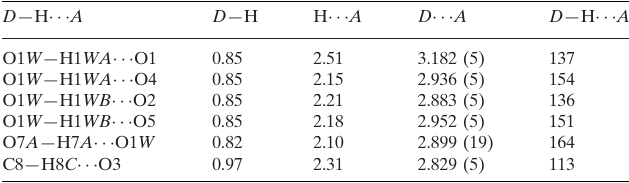
Bruker SMART APEXII CCD area-detector diffractometer Absorption correction: multi-scan ( SADABS ; Bruker, 2005) T min = 0.804, T max = 0.923